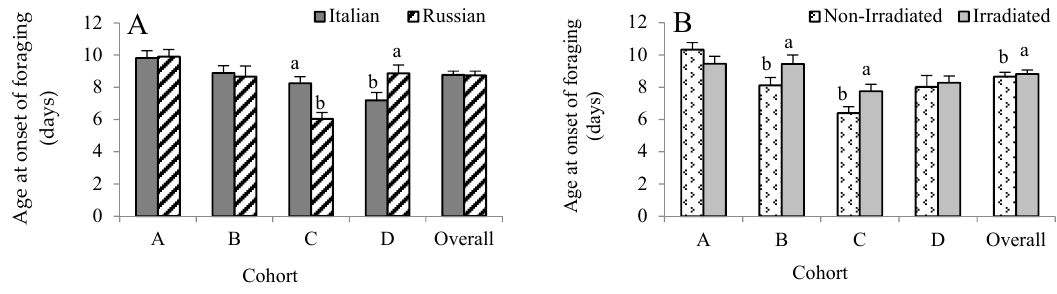
Figure 1. Effects of honey bee stock ( A ) and comb irradiation on age at onset of foraging ( B ) (mean ± standard error). For each cohort, bars with the same letters are not significantly different ( p >0.05). In total, 340 RFID-tagged Russian and 349 Italian honey bees were analyzed (see Table 1).